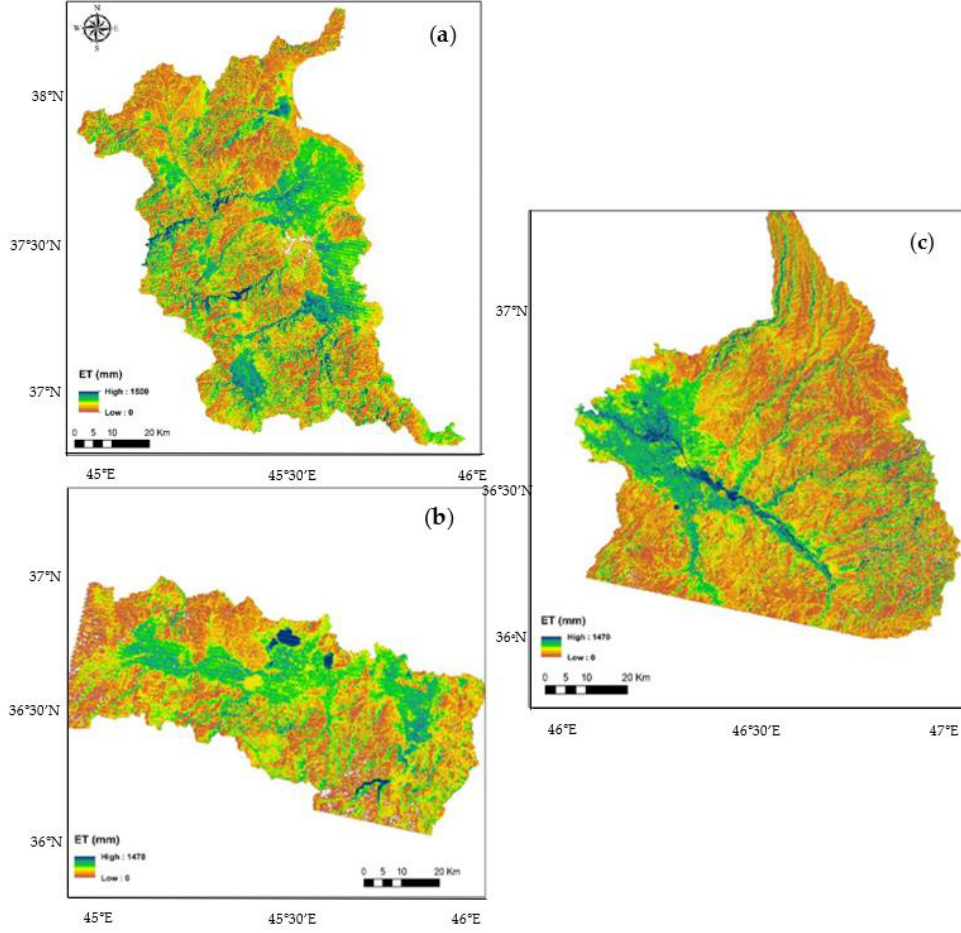
Figure 5. Seasonal ET maps for ( a ) west of Lake Urmia Basin (WLUB), ( b ) southwest of Lake Urmia Basin (SWLUB), and ( c ) south of Lake Urmia Basin (SLUB). According to the common terminology of blue and green water used by Falkenmark and Rockström [66], the majority of the water consumed for irrigation during this period is extracted from surface and groundwater resources, which are considered blue water. By comparing the water used by each crop, it can be perceived that the degree of ET varies slightly at different sites but at some points it touches the ET0 line. Being below the ET0 line implies that crops may undergo water stress during the growing season due to the water